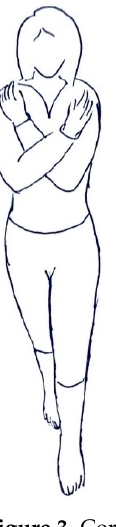
Figure 3. Correct positioning of the feet “heel to toe” in the Romberg sharpened test—tandem stance (the dominating lower limb at the front position). (the dominating lower limb at the front